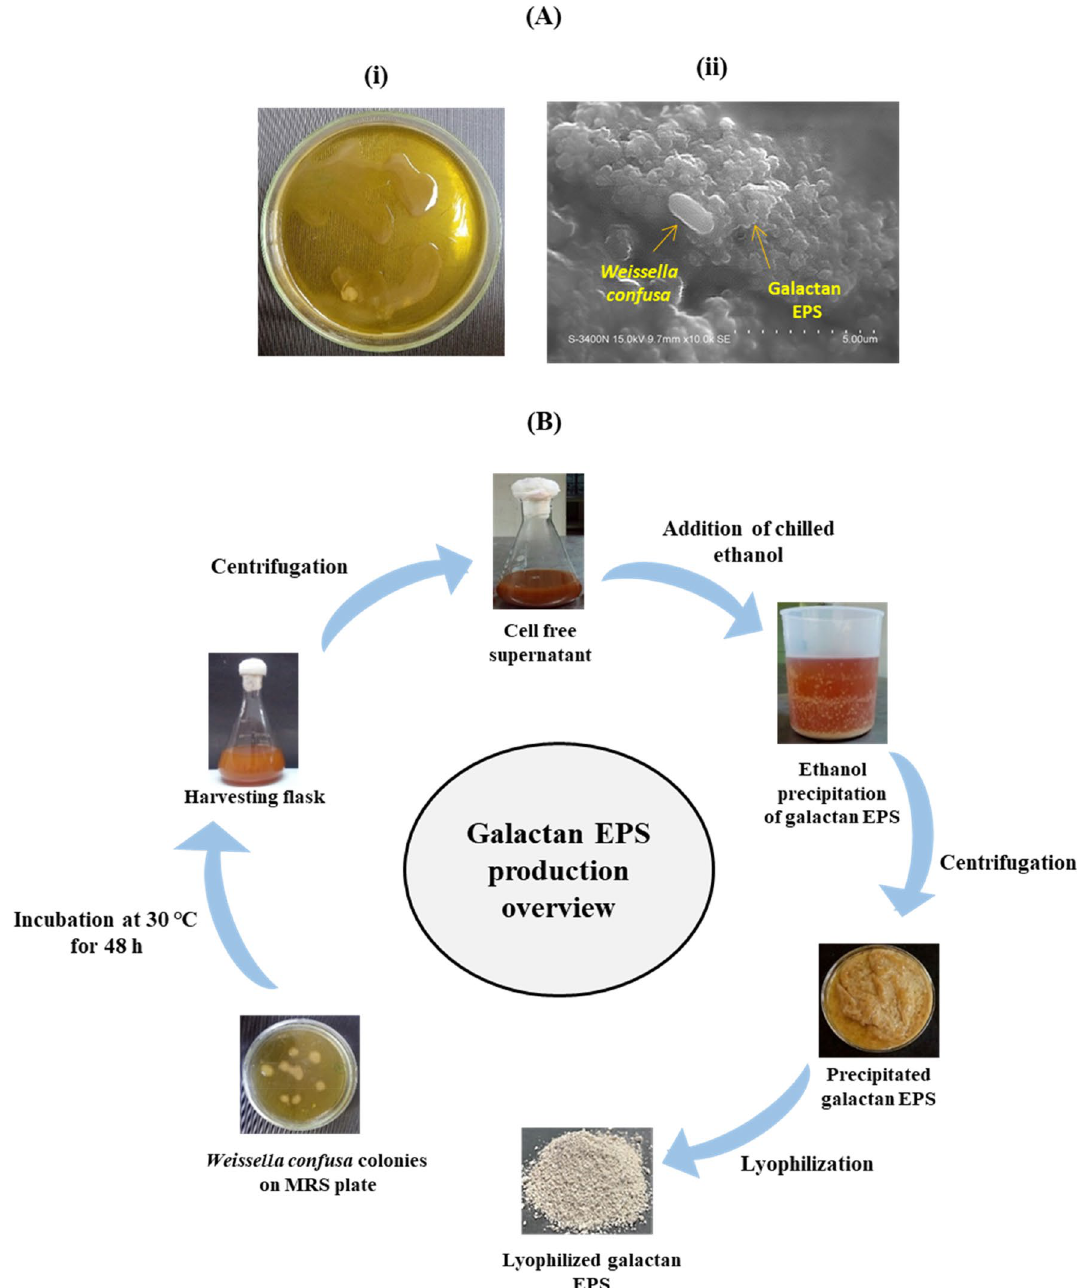
Figure 1. ( A ) Detection of galactan EPS production from Weissella confusa KR780676: ( i ) Weissella slimy colonies on MRS agar enriched with 2% sucrose, incubated for 48 h ( ii ) SEM analysis of Weissella colony showing presence of galactan EPS along with cells. ( B ) Overview of galactan EPS half-maximal effective concentration (IC 50 ) of ascorbic acid was 8.8 µg/mL, while galactan EPS was 450 µg/mL. 1,1-diphenyl-2-picrylhydrazyl (DPPH) is a stable free radicle which delocalizes the unpaired electrons against the molecule as a whole, thus prevents the molecules from dimerization and results in deep violet color 59 . When DPPH solution is added to different concentrations (50 to 500 µg/mL) of galactan, it gives rise to a reduction of violet color as the concentration increased. Antioxidants when reacting with an electron of DPPH, the deep violet color of DPPH turns to light violet color; and the intensity of the color depends on the antioxidant activity of the substrate 60 . Galactan showed 60% DPPH scavenging potential which is higher than EPS from endophytic bacterium Paenibacillus polymyxa EJS-3 (< 45.40%) 33 . Nitric oxide is produced when sodium nitroprusside is decomposed in an aqueous solution at a pH of 7.2. Nitrate and nitrite are produced under aerobic conditions when nitric oxide binds with oxygen 61 . As shown in